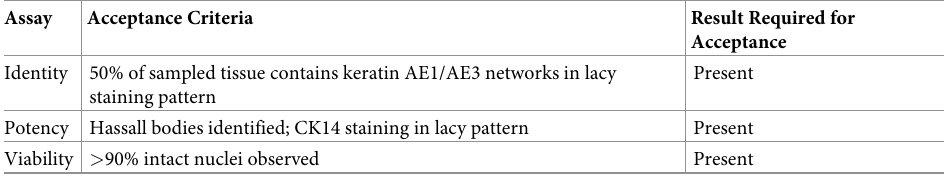
Table 1. Diagnostic criteria for thymus submitted on day 0 �